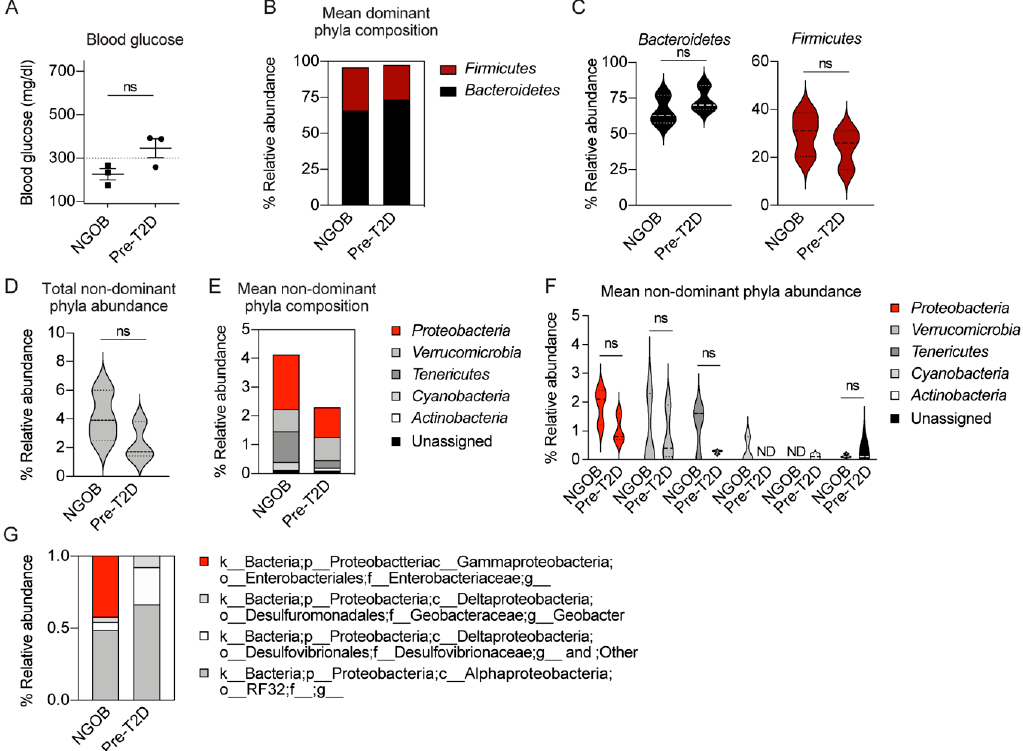
Figure 2. An altered gut microbiota composition is associated with T2D resistance vs. susceptibility BTBR Ob mice: ( A ) random-fed blood glucose levels of two female and one male mouse per group, where data represent mean ± SEM and ns represents not significant; ( B ) bar plot of dominant phyla; ( C ) violin plots of individual dominant phyla; ( D ) violin plots of total nondominant phyla; ( E ) bar plot of nondominant phyla; ( F ) violin plots of individual nondominant phyla; and ( G ) bar plot of individual proteobacteria orders as a fraction of the total proteobacteria abundance. Data represent mean ± SD and population density. In ( C , D , F ), data were compared by t -test. ns = not significant.